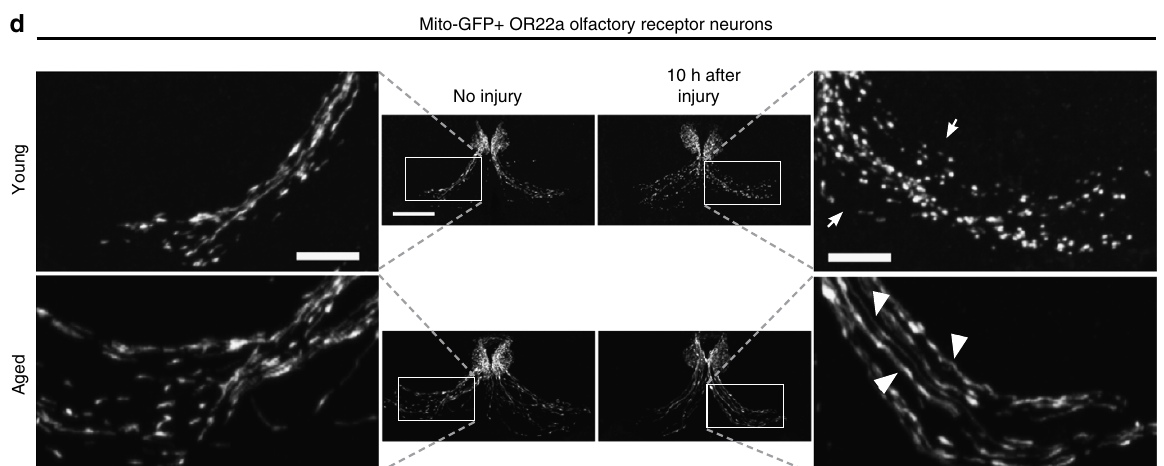
Figure 7 | WD of severed ORNs is delayed in aged animals. ( a ) Representative Z -stack projections shown from young and aged brains 6h post-axotomy. Draper (magenta) accumulation is visible on young axons at this time point (white arrows). Scale bar, 30 m m. Zoomed images of axons (right) are from white, boxed regions. Scale bar, 10 m m. ( b ) Representative images of young and aged axons expressing membrane-tethered GFP from uninjured (D0) animals and 1 day (D1) or 3 days (D3) after injury in glial Draper-depleted flies. Scale bar, 30 m m in the left panel and 5 m m in higher magnification panels. ( c ) Blind scoring analysis of fragmentation status of young and aged axons 1 day (D1), 2 days (D2) or 3 days (D3) post-axotomy shown in b . ( d ) Representative projections of young and aged flies expressing mito-GFP in a subset of olfactory axons before and 10h after axotomy. mito-GFP pattern appeared punctate after injury in young animals (white arrows) but continuous in aged axons (white arrowheads). Scale bar, 30 m m in central panels and 10 m m for magnified images. Genotypes: a , w 1118 ; OR85emCD8:: GFP/ þ . b , c , w 1118 ; OR85emCD8:: GFP/ þ ; repo-Gal4/UAS-Draper RNAi . d , OR22a-Gal4/UAS-mito-HA-GFP